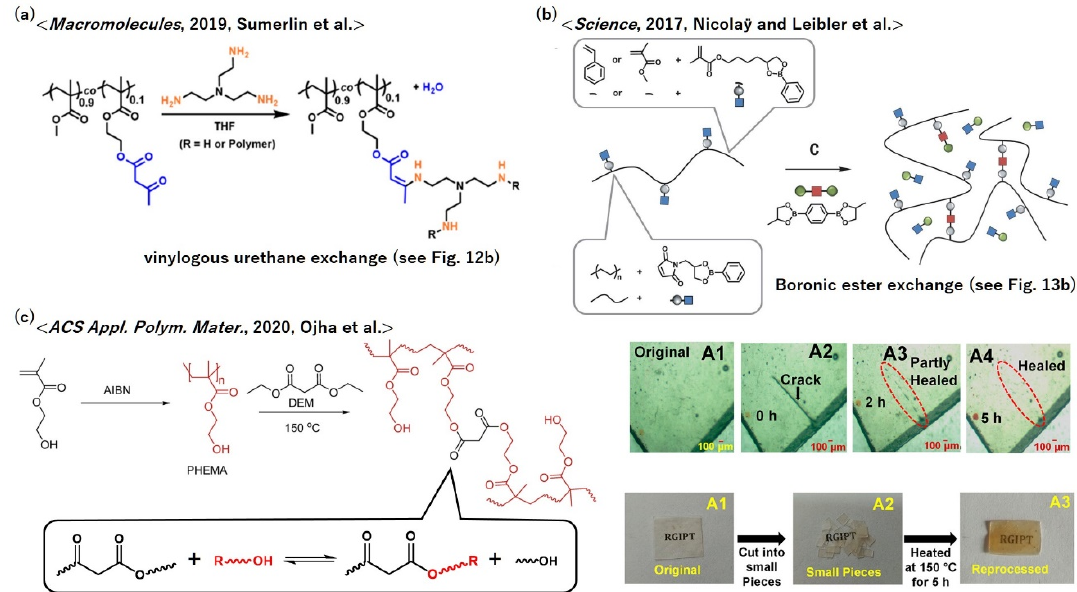
Figure 16. ( a ) Molecular designs of vitrimer poly(meth)acrylates according to ( a ) ref. [67], ( b ) ref. [68], and ( c ) ref. [69]. In ( c ), visual representations of scratch healability and recyclability are also shown, where the sample was heated at 150 °C for the healing test. ( a ) Adapted with permission from ref. [67]. Copyright (2019) American Chemical Society. ( b ) From (Rottger, M.; Domenech, T.; van der Weegen, R.; Breuillac, A.; Nicolaÿ, R.; Leibler, L, Science , 356 (6333), 62–65 (2017)). Reprinted with